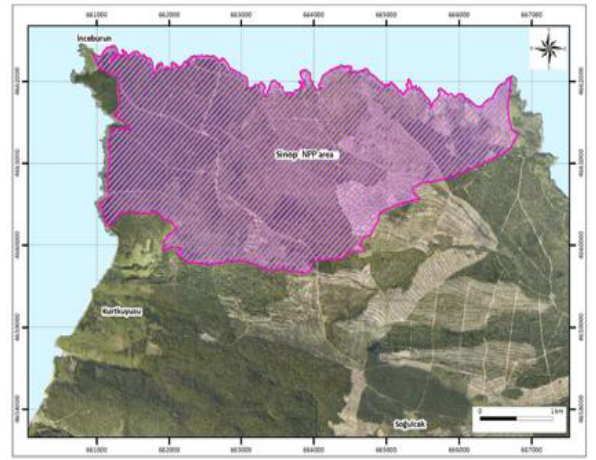
Figure 3. Sinop nuclear power plant project area (Sinop NGS projesi, 2017).